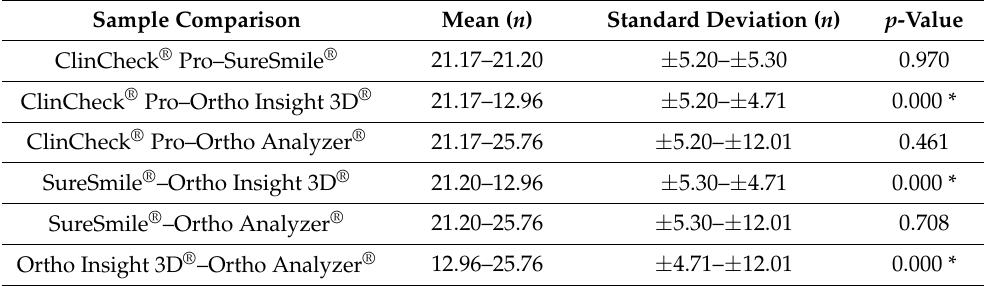
Table 5. Pairwise comparison for number of mandibular aligners.